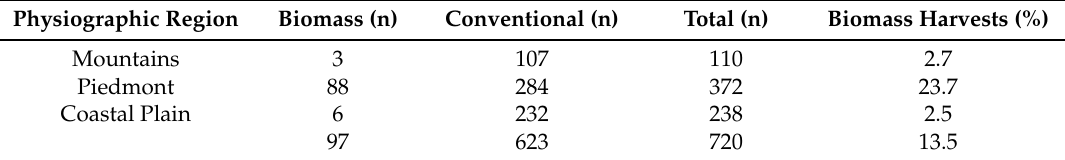
Table 1. Distribution of biomass and conventional harvest tracts across physiographic regions.